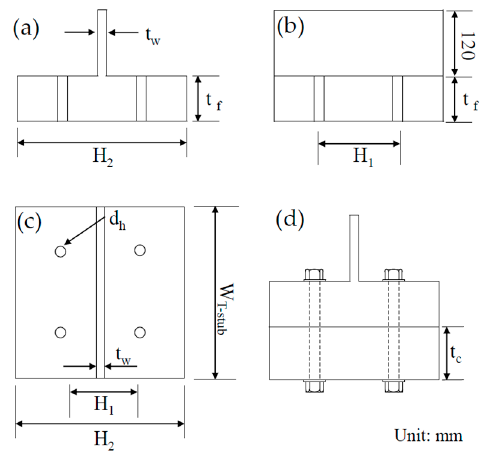
Figure 6. Component details: ( a ) Front view; ( b ) side view; ( c ) plan view; ( d ) test setup.